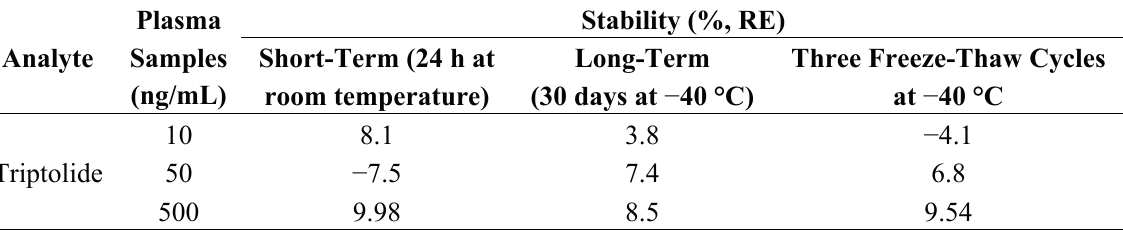
Table 2. Stability of triptolide in plasma samples (n = 3).